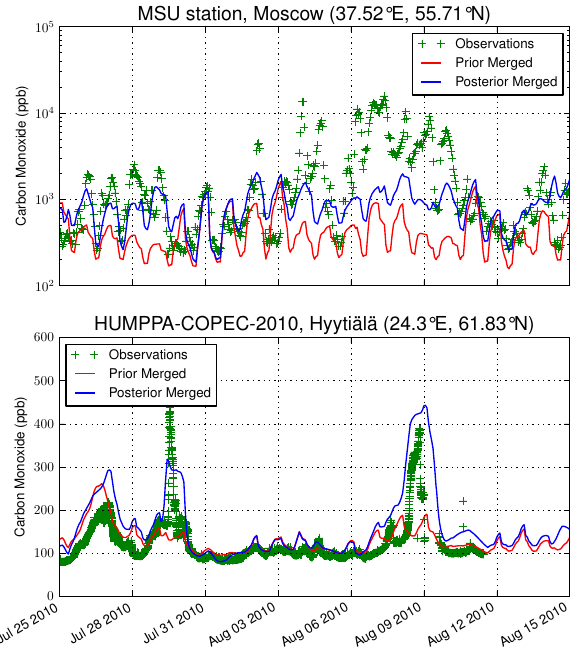
Fig. 5. Modelled and observed CO mixing ratios at the MSU sta- tion in Moscow (upper panel, logarithmic y-axis) and in Hyyti¨al¨a, Finland (lower panel, normal y-axis). The red line denotes the TM5 simulation with prior MERGED emissions (see Table 1). The blue line denotes the TM5 model simulation with optimised MERGED emissions. Green symbols are the